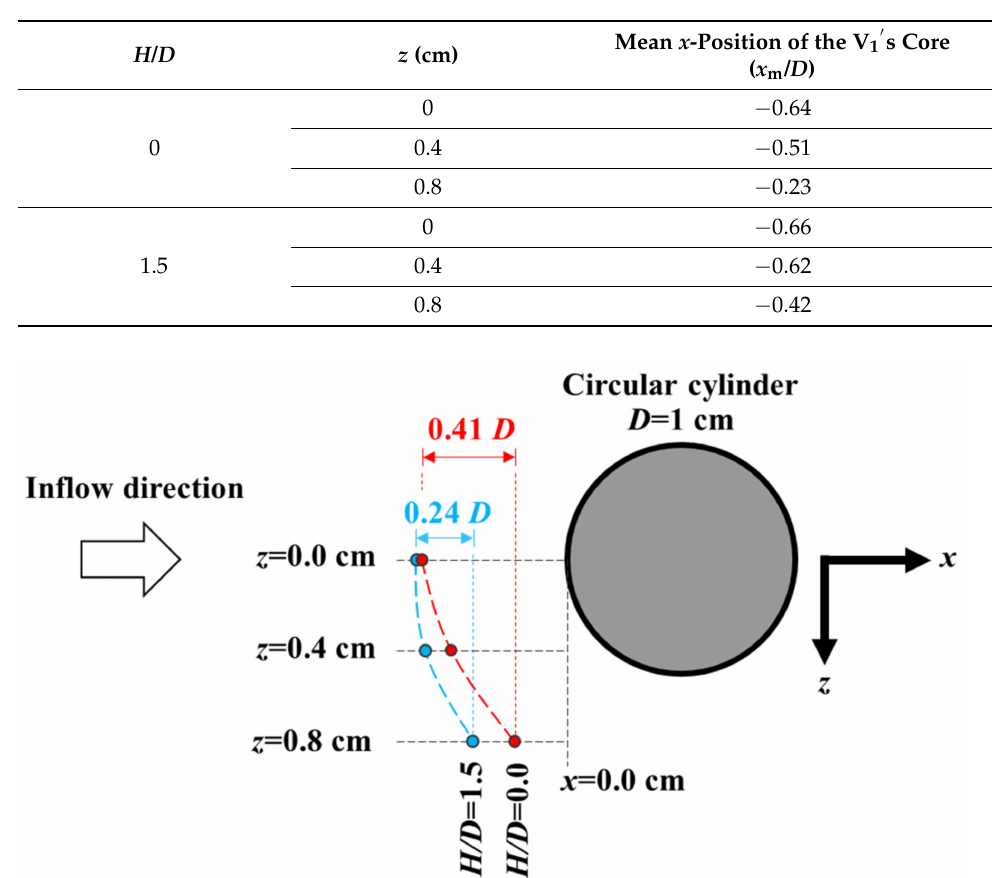
Table 2. Mean x-positions of the HSV at the “oscillation with a small displacement” mode when H / D = 0 and 1.5.